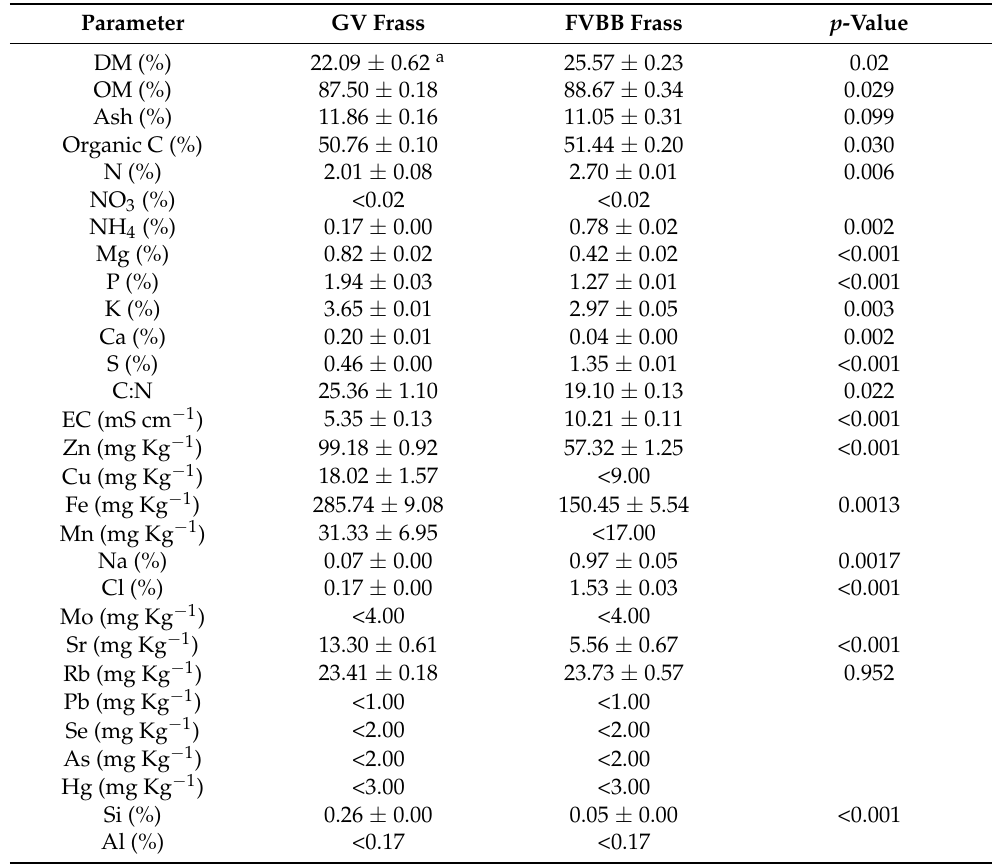
Table 4. Chemical composition of Gainesville (GV frass) and fruit/vegetable/bakery/brewery (FVBB frass)